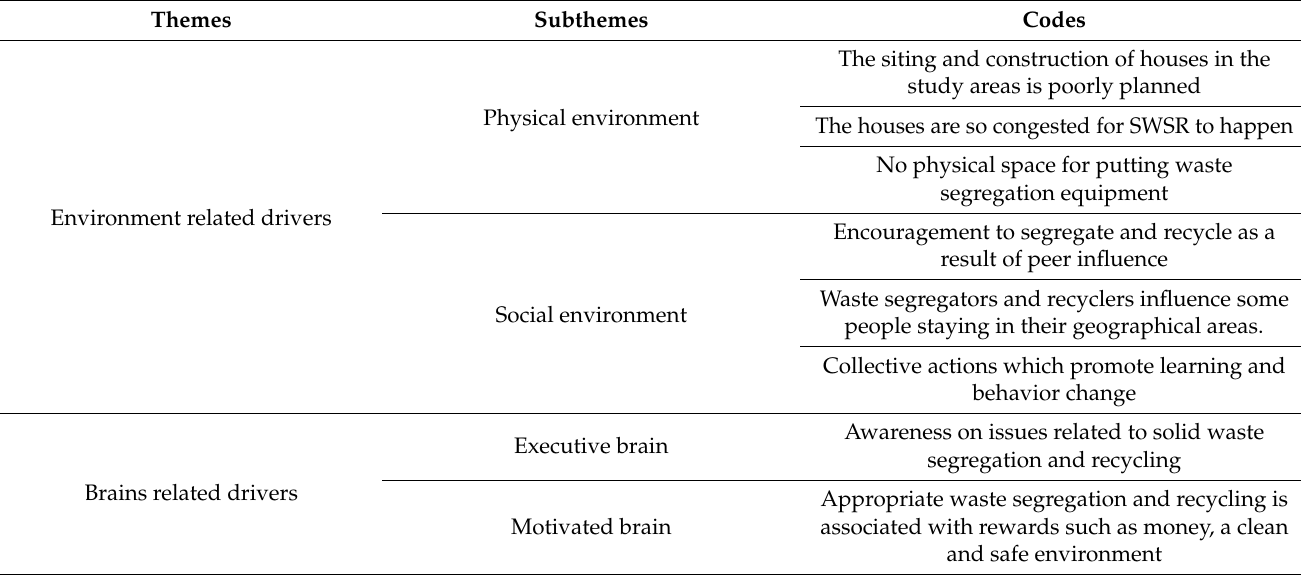
Table 3. Linkages between codes, subthemes and